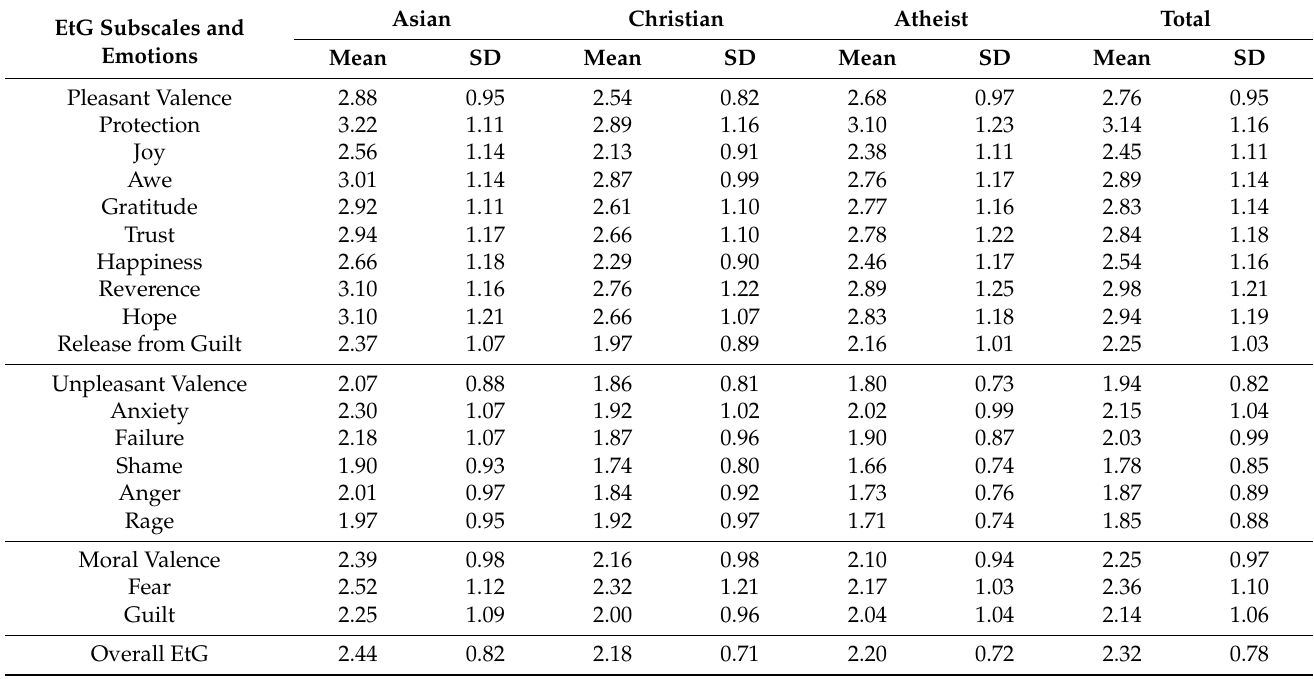
Table 5. Cross-tabulation between EtG subscales and religious